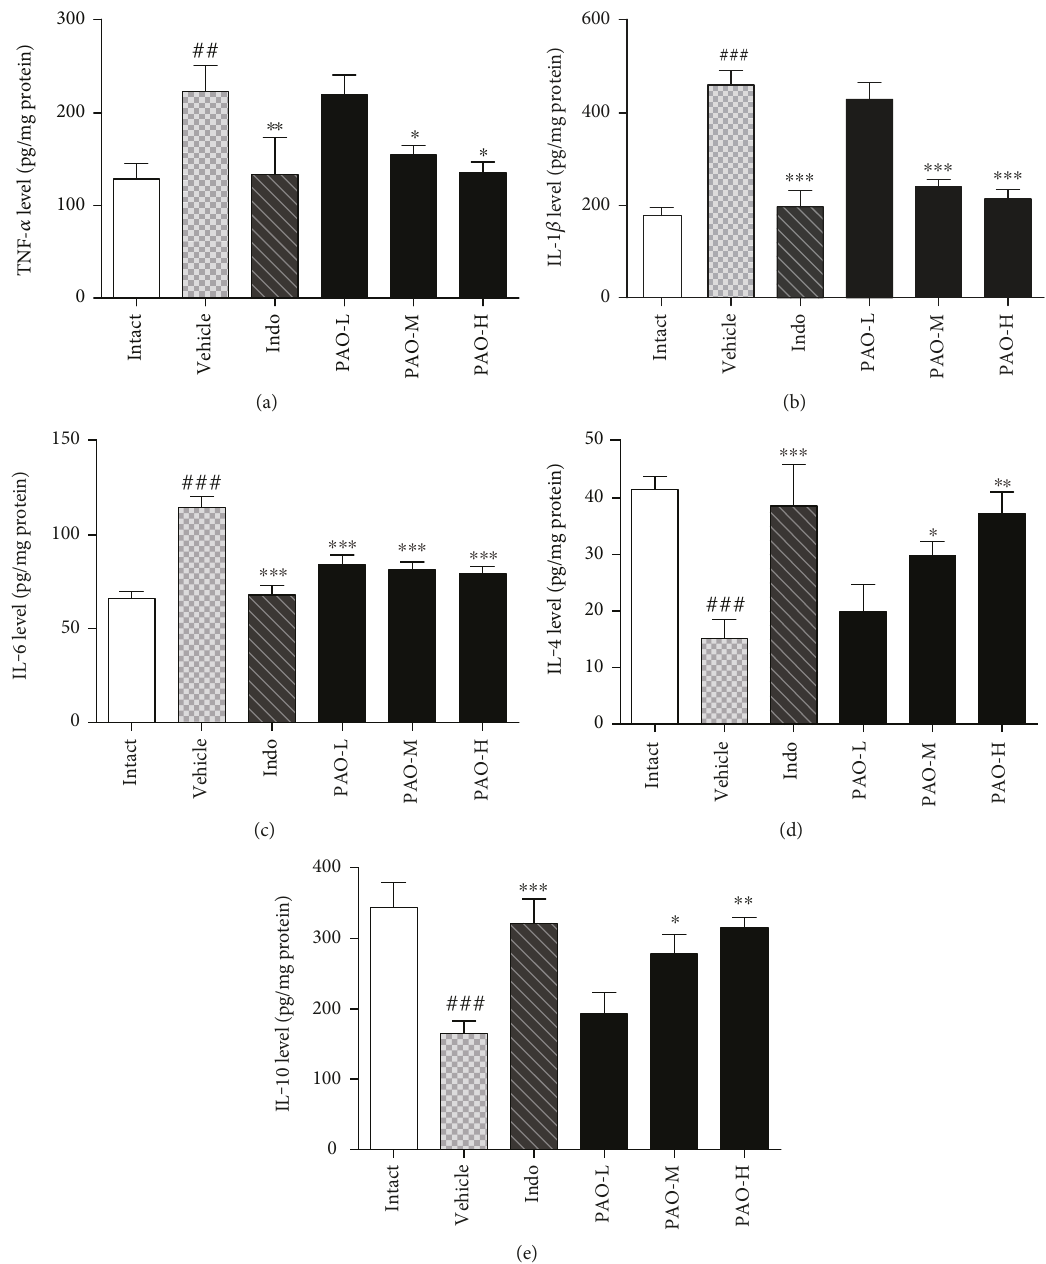
Figure 6: E ff ect of PAO on the levels of TNF- α (a), IL-1 β (b), IL-6 (c), IL-4 (d), and IL-10 (e) in carrageenan-induced mouse paw. Indo: indomethacin (10 mg/kg); PAO-L: low dose of PAO (10 mg/kg); PAO-M: medium dose of PAO (20 mg/kg); PAO-H: high dose of PAO (40 mg/kg). Data were expressed as means ± SEM. ( n = 10 ), ## p < 0 01 , ### p < 0 001 versus the intact group. ∗ p < 0 05 , ∗∗ p < 0 01 , and ∗∗∗ p < 0 001 versus the vehicle